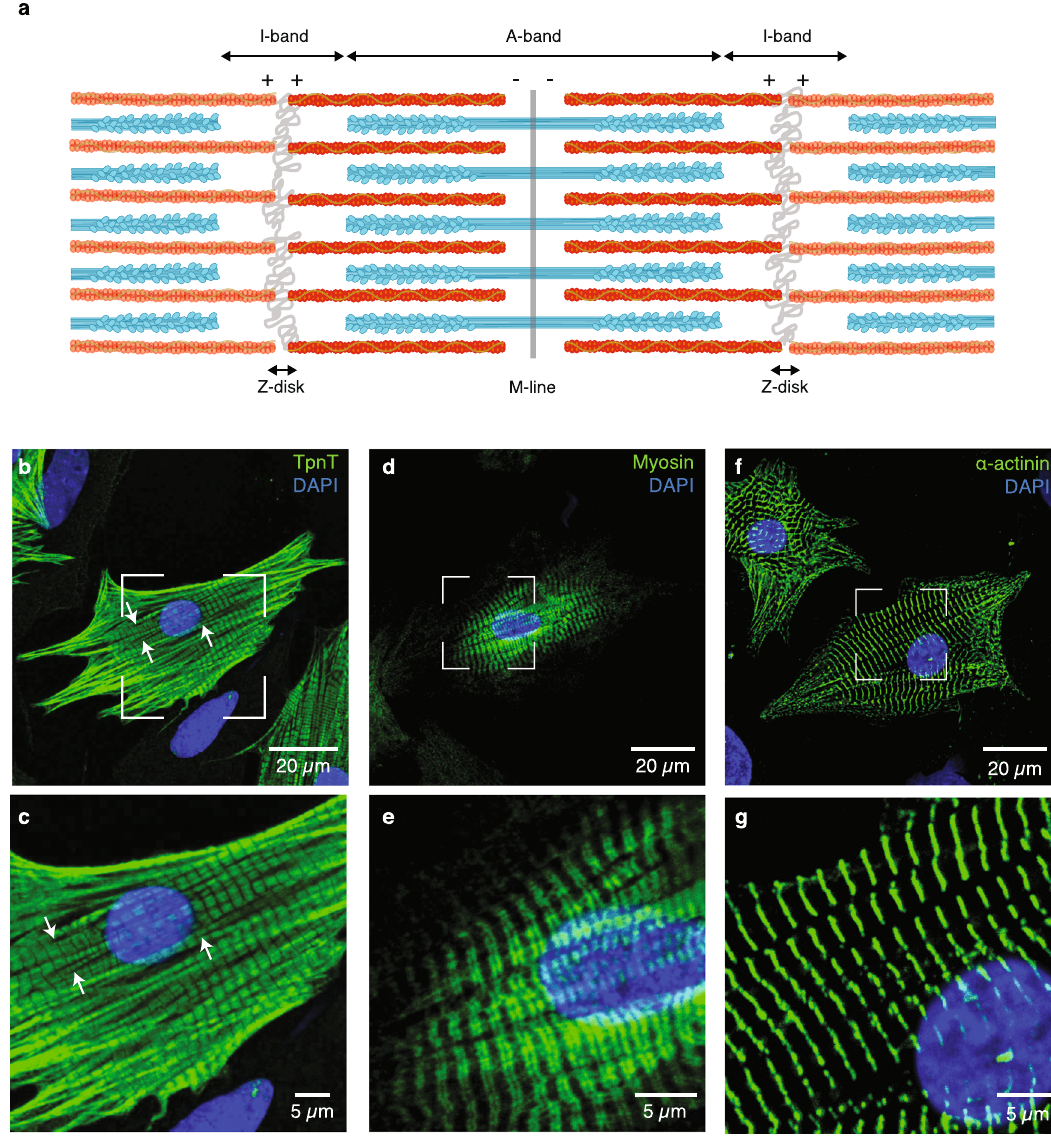
Fig. 1 Myo fi brillar organization in neonatal rat cardiomyocytes at the microscale. a Schematic representation of adjoining micrometer-sized sarcomeres within a myo fi bril, showing the organization of the thick (cyan) and thin (red) fi laments in this basic contractile unit of striated muscle. Neonatal rat cardiomyocytes were labeled with antibodies speci fi c for troponin T (TpnT; b , c ), the heavy chain of myosin (Myosin; d , e ), and α -actinin ( f , g ), respectively. Thin ( b , c ) and thick ( d , e ) fi laments assemble into myo fi brils, which align along the main axes of the star-like shaped cells and display regularly spaced Z-disks ( f , g ). Myo fi bril branching is indicated with white arrows. c , e , g Zoomed-in views of the framed regions in b , d , f , respectively. A minimum of three biologically independent experiments were performed in each